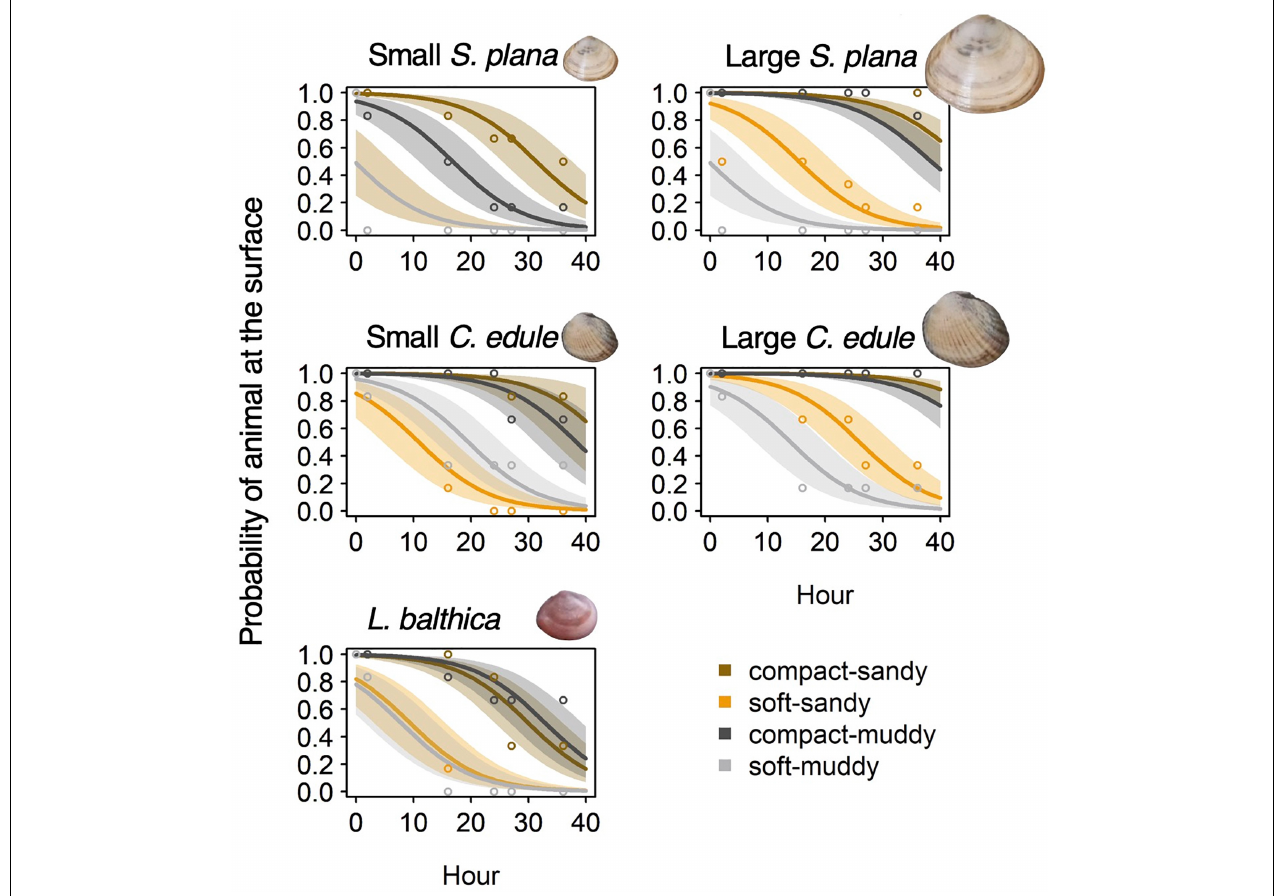
FIGURE 3 | Logistic regression models of bivalve burrowing showing the probability of a bivalve’s presence at the sediment surface over the first 40 h of the experiment. The results are shown by species and sediment treatment, with best fit line and 95% confidence intervals. Mean observed values per time-step are depicted by open